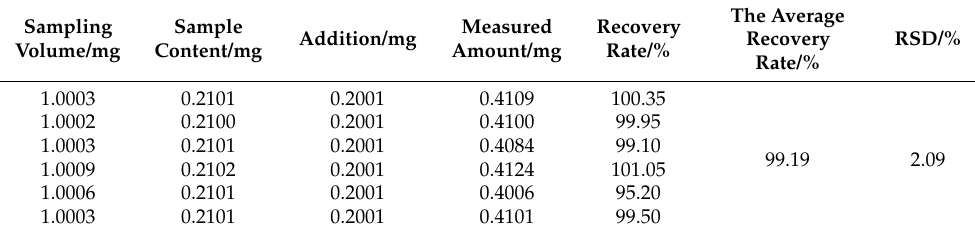
Table 2. Test results of naringenin sample recovery rate.